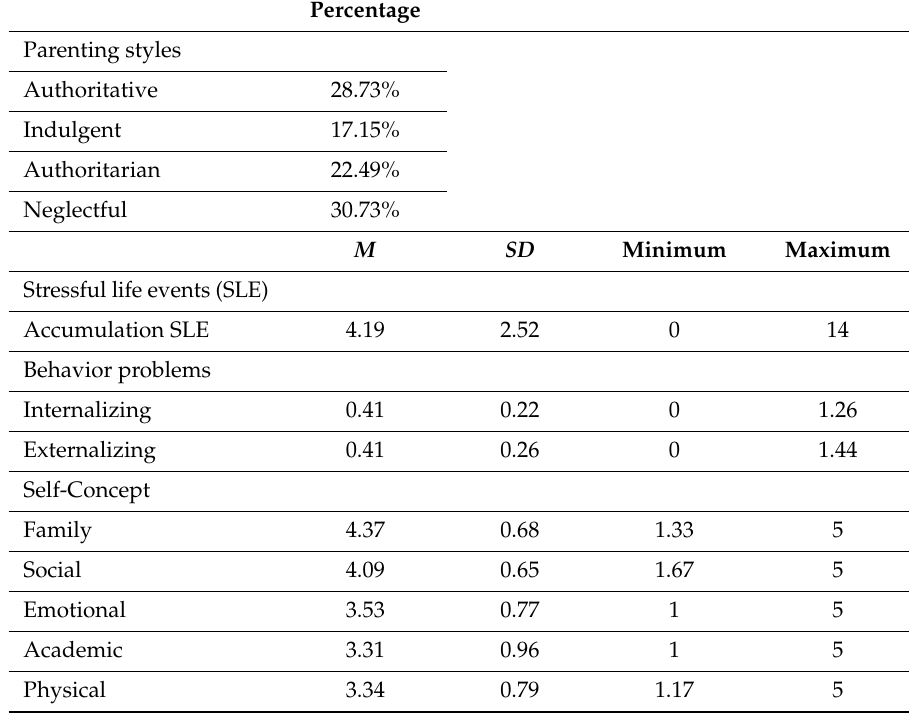
Table 1. Descriptions of parenting styles, behavior problems, self-concept, and stressful life